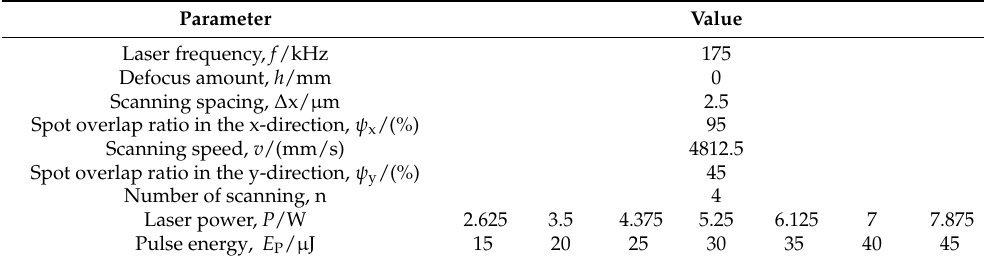
Table 3. Experimental parameters of femtosecond laser polishing of SiC ceramics with variable pulse Table 2. The femtosecond laser ablation experimental parameters of SiC ceramics.